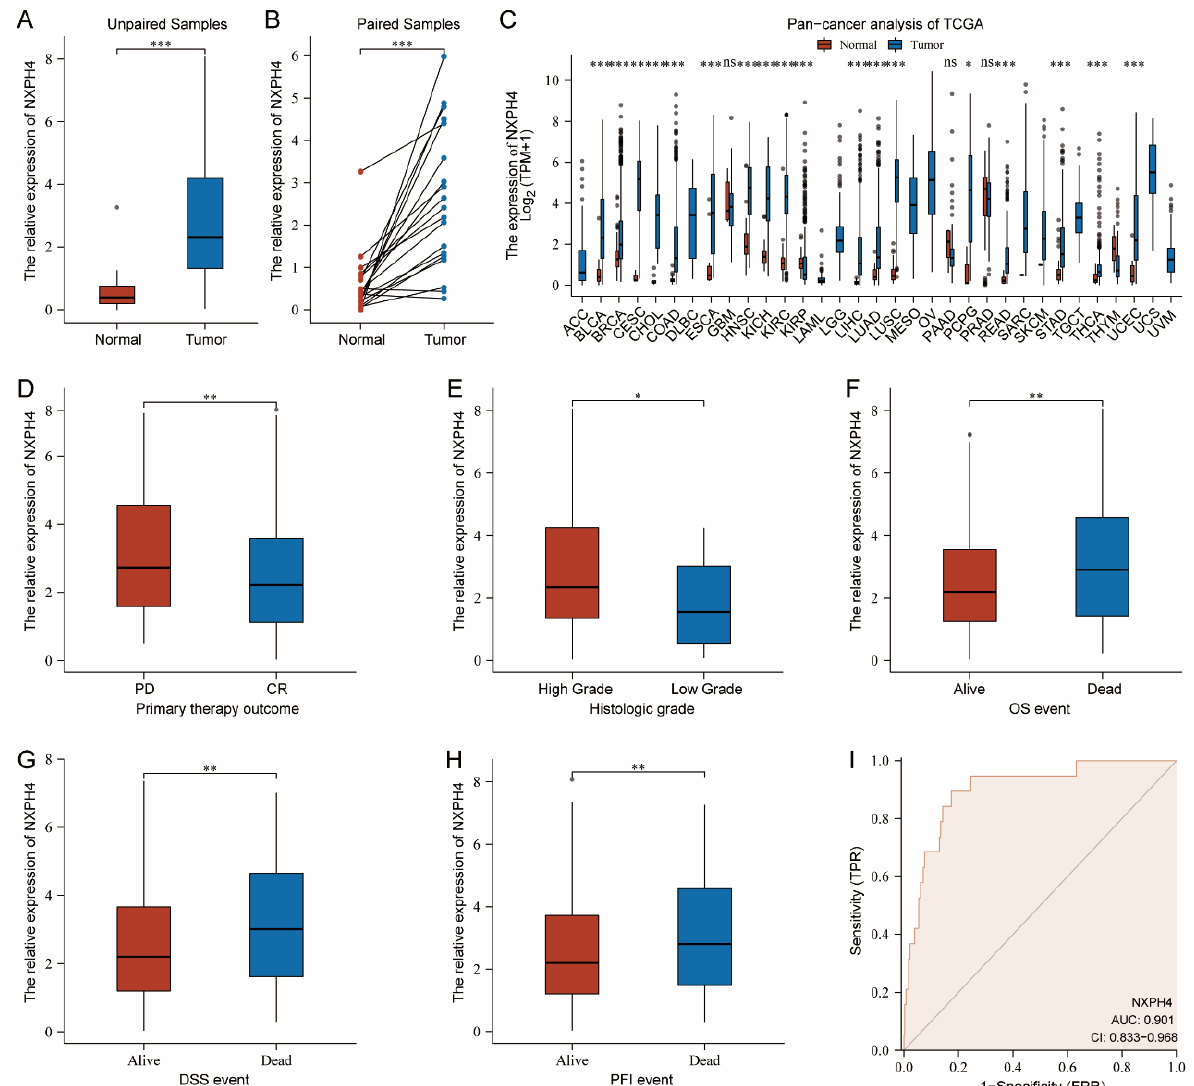
Figure 1. Bioinformatic analysis reveals the abnormal expression of NXPH4. ( A – C ) The distinct expression levels of NXPH4 in various kinds of cancers. ( D ) In contrast to patients with complete response, patients with progressive disease had higher levels of NXPH4. ( E ) The patients with bladder cancer of higher grade also experience higher expression of NXPH4 ( F – H ). Patients experiencing OS, DSS, and PFI have higher expression of NXPH4. ( I ) The receiver operating characteristics of NXPH4 in bladder cancer tissues and normal bladder tissues, * p < 0.05; ** p < 0.01; *** p <